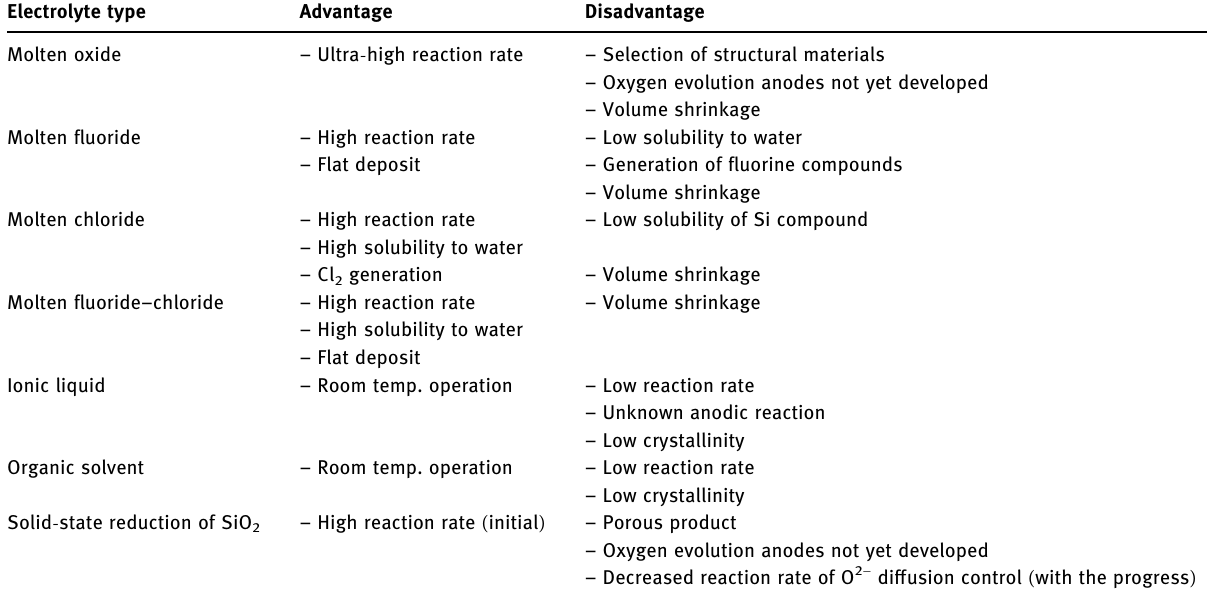
Table 10: Feature of each electrolyte on electrochemical production of Si Electrolyte